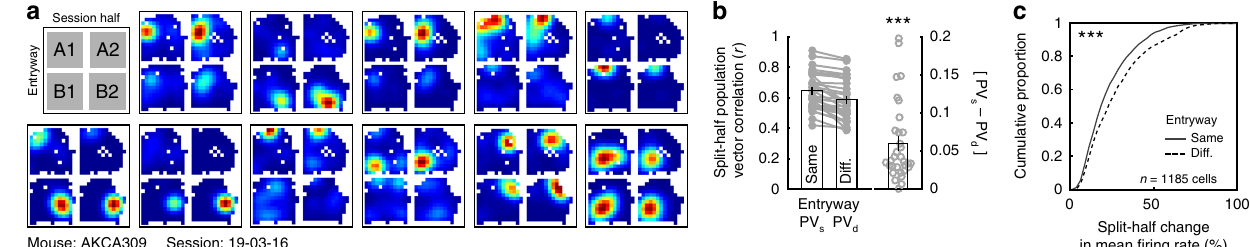
Fig. 2 The CA3 rate code depends on entryway. a Example rate maps from 11 simultaneously recorded place cells when the data are divided by entryway and session half. Rate maps are normalized from zero (blue) to the peak (red) across all four maps. b Split-half correlations of population activity within the compartment when the mouse entered from the same versus the different entryway. Each dot represents one session from one mouse. Data are from 32 sessions from 4 mice. Correlations were signi fi cantly higher when the mouse entered from the same entryway (Wilcoxon signed-rank test: Z = 4.937, p = 7.95e – 7). c Cumulative distribution of split-half changes of mean fi ring rates within the compartment when the mouse entered from the same versus the different entryway. Mean fi ring rates were signi fi cantly more similar when the mouse entered from the same entryway (Wilcoxon rank-sum test: Z = 5.150, p = 2.61e – 7). All bar graphs re fl ect mean ±1 SEM; p -values are uncorrected and two-sided. Data from ( b , c ) provided as Source data fi le. *** spatial sampling distributions across entryways and halves prior